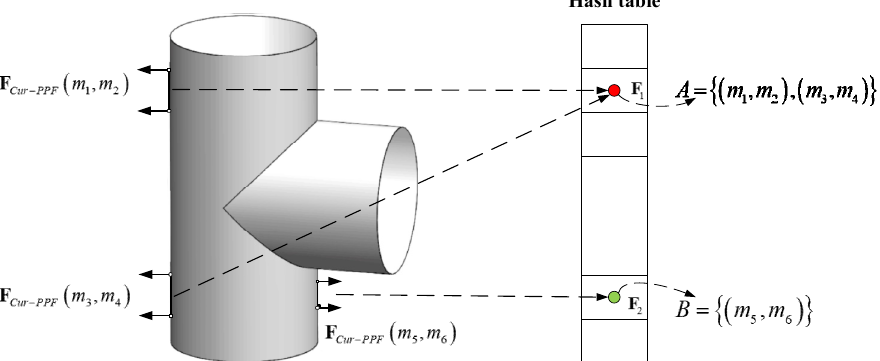
Figure 4. The hash table model. For the three point-pairs on the model, because point-pairs ( m 1 , m 2 ) and ( m 3 , m 4 ) have the same feature description, these two point-pairs are stored in the same slot of the hash table, and the key of the slot is represented by the feature F 1 of these two point-pairs; the feature description of point ( m 5 , m 6 ) is different from F 1 , so it is stored in another slot of the hash table, which is represented by feature F 2 .